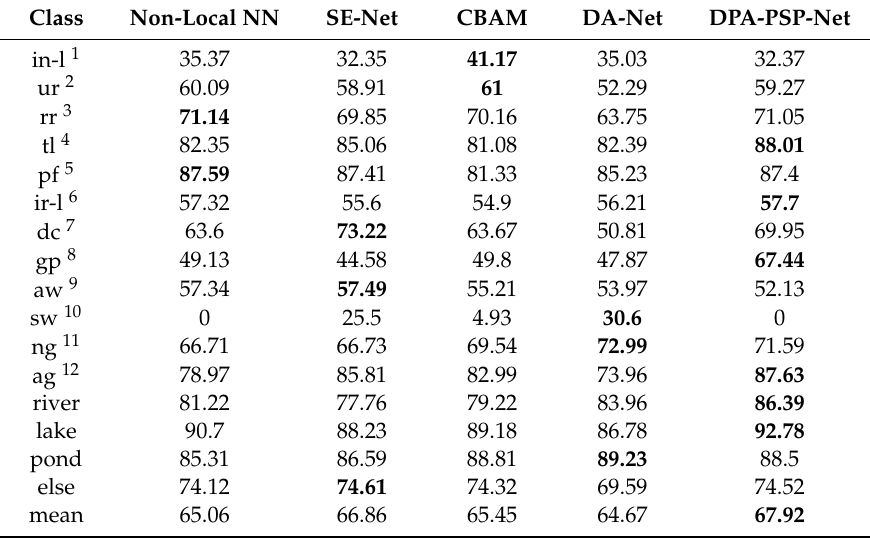
Table 7. Mean IoU for each category of the di ff erent self-attention models.